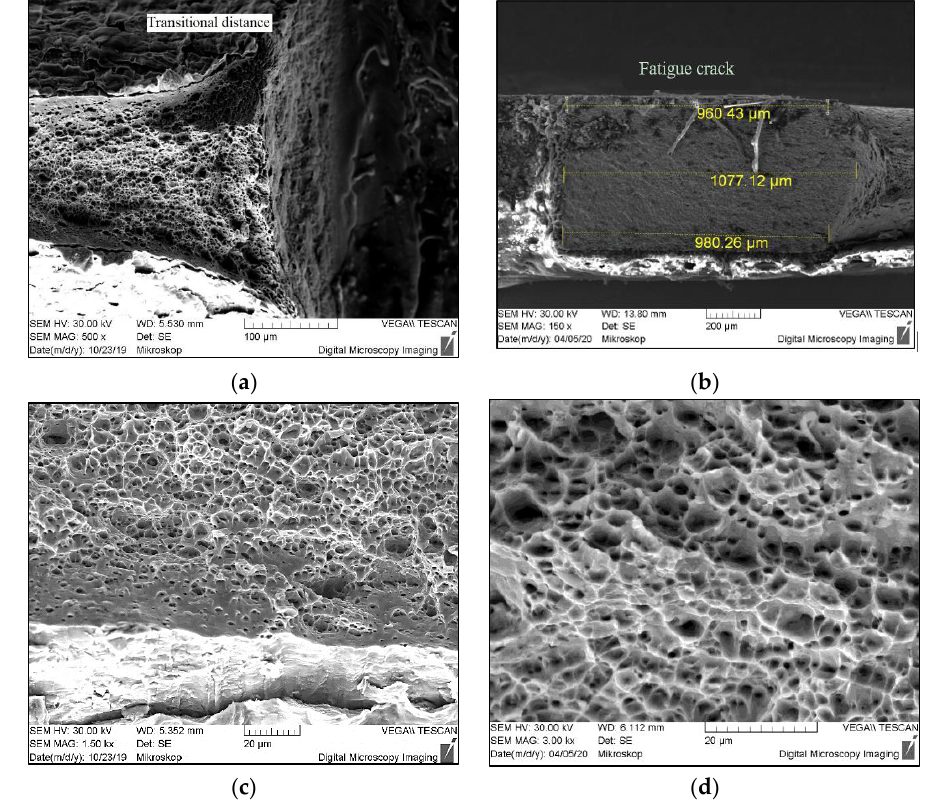
Figure 8. Scanning electron microscope (SEM) images of the fractured surface after essential work of fracture (EWF) testing: ( a ) Crack tip of a notched sample; ( b ) Crack tip of a fatigue pre-cracked sample; ( c ) Ductile and slant fracture at edge; ( d ) Flat and ductile fracture at centre.